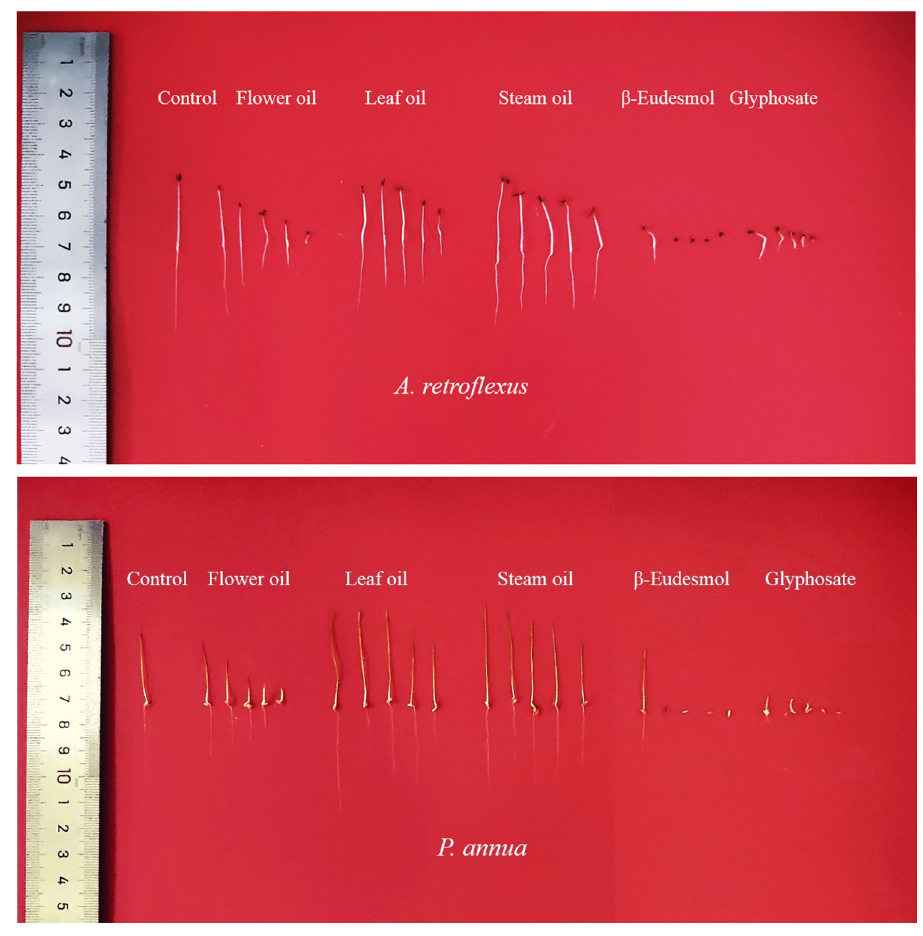
Figure 5. Phytotoxic effect of flower, leaf, and stem oil of O. acanthium , β-eudesmol, and glyphosate (concentration tested ranging from 0.25–5 mg/mL) on seedling growth of A. retroflexus and P. annua .